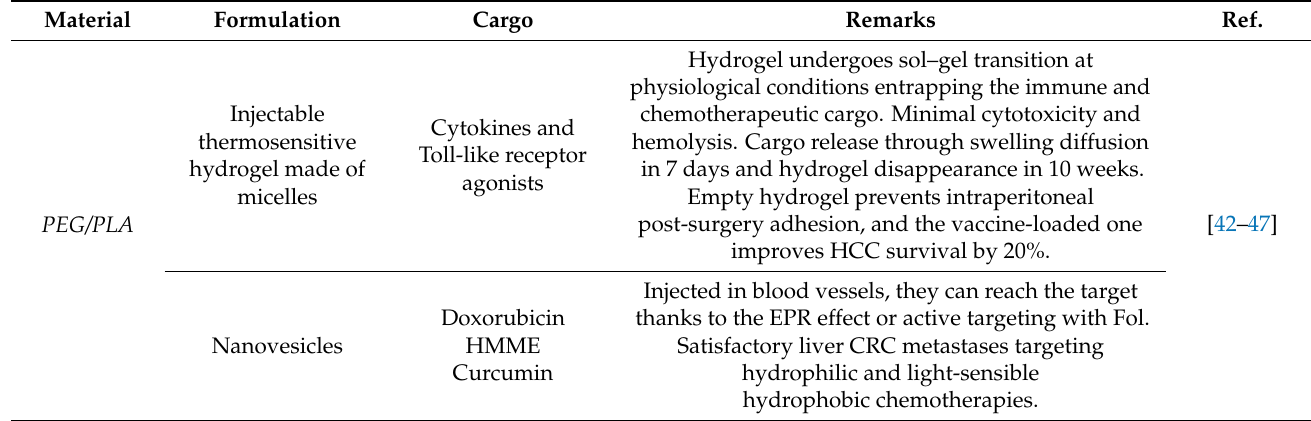
Table 1. Different delivery systems, divided for material implied, aimed to hinder hepatocellular carcinoma and colorectal cancer metastatic behavior. Here examples of possible cargos are reported, together with some remarks for every type of biomaterial, showing some pros and